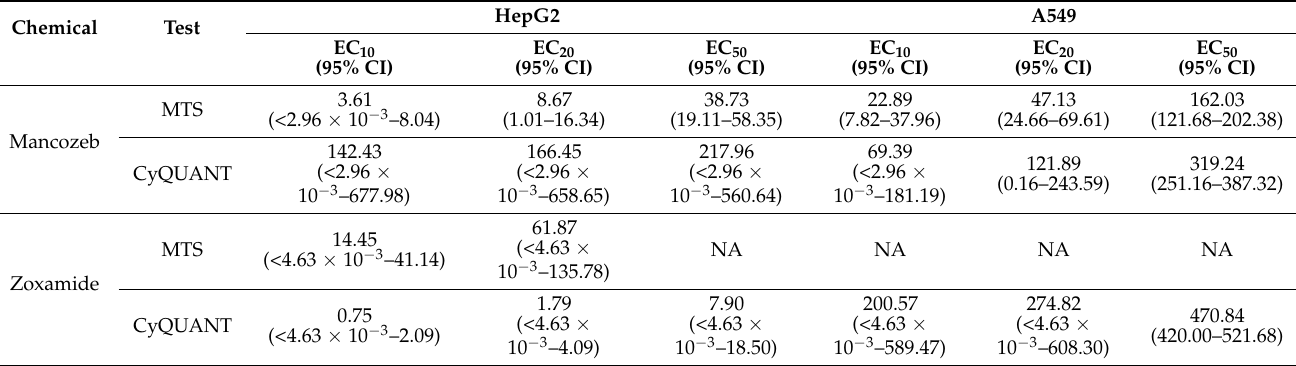
Figure 1. Dose – response curves of CyQUANT (black lines) and MTS (blue lines) assays in HepG2 and A549 cells treated with MZ and ZOX for 24 h. Values are means ± standard error of the mean (SEM) of three independent experiments normalized to the solvent control (0.8% DMSO for MZ; 0.2% DMSO for ZOX). Statistical significance is indicated by asterisks: * p < 0.05; ** p < 0.01; *** p < 0.001. Table 2. EC 10 , EC 20 and EC 50 expressed in µ M concentrations, calculated from dose–response curve of CyQuant and MTS assays in HepG2 and A549 cells treated with MZ and ZOX for 24 h. NA (not available).